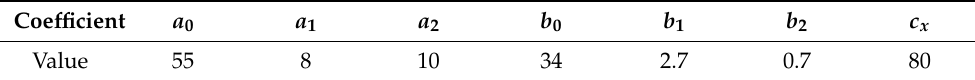
Table 1. Coefficients for the Dörr and Kloker model.